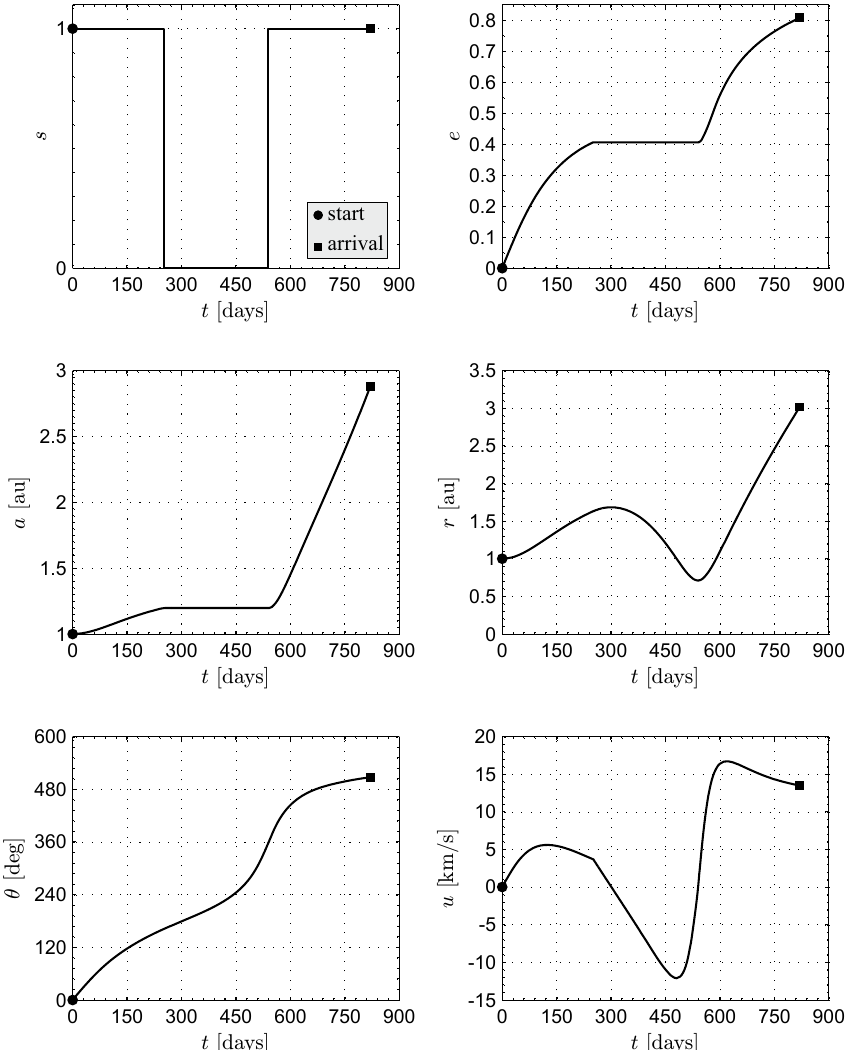
Figure 17. Transfer trajectory characteristics in a Jupiter-based mission scenario with e f = 0.8077 and β =